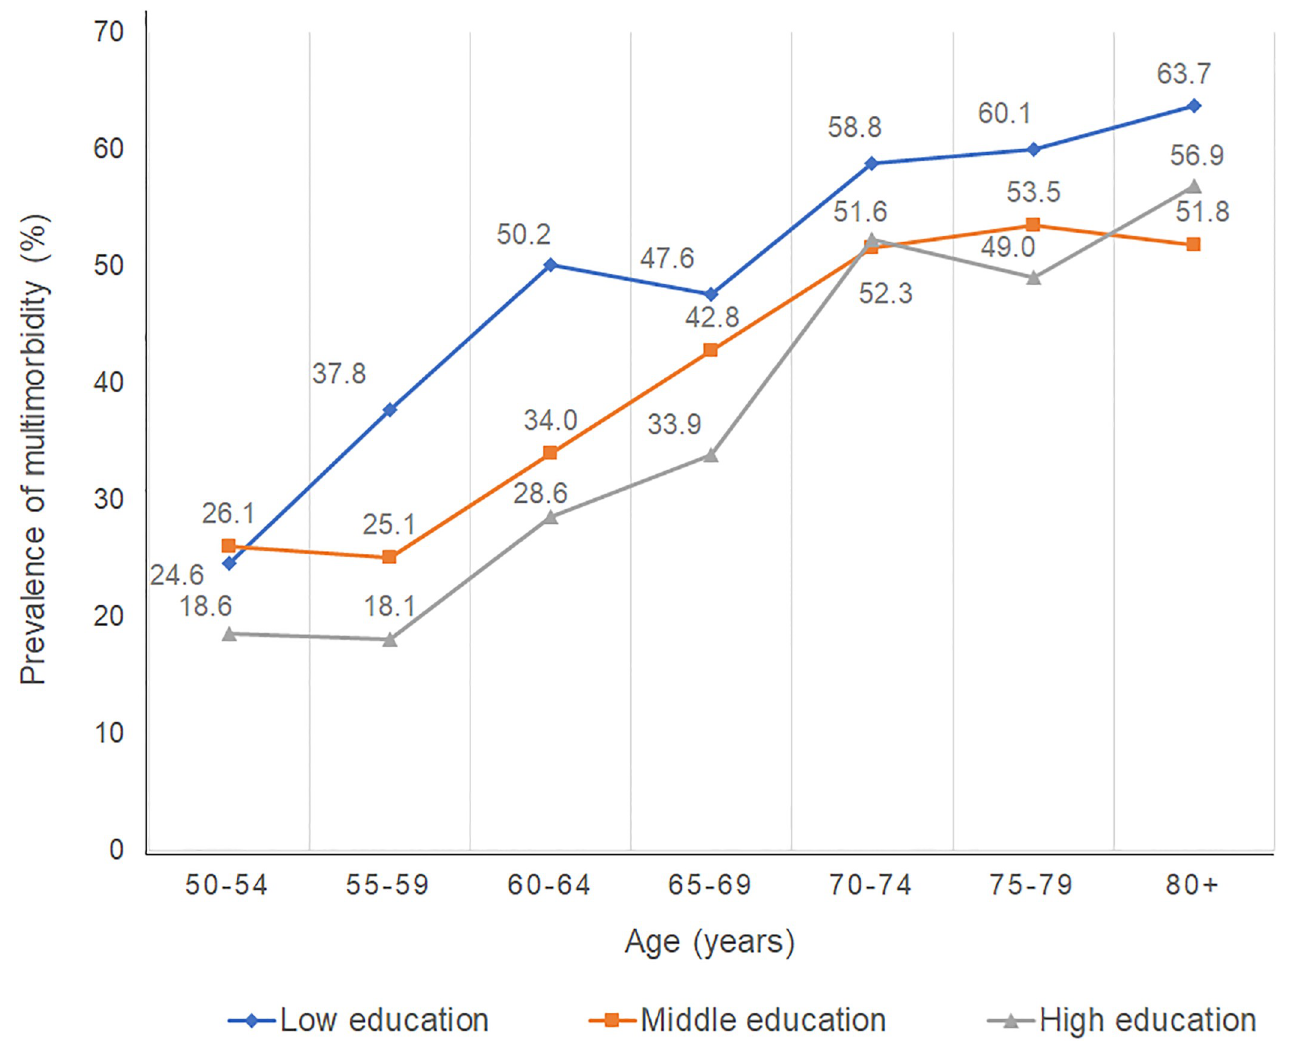
Fig 3. Prevalence of multimorbidity stratified by education level and age (Australia) + . + The 12 non-communicable diseases (NCDs) include arthritis, cancer, type 1 diabetes, type 2 diabetes, heart diseases, hypertension, asthma, bronchitis, depression, anxiety, other mental diseases, circulatory conditions.